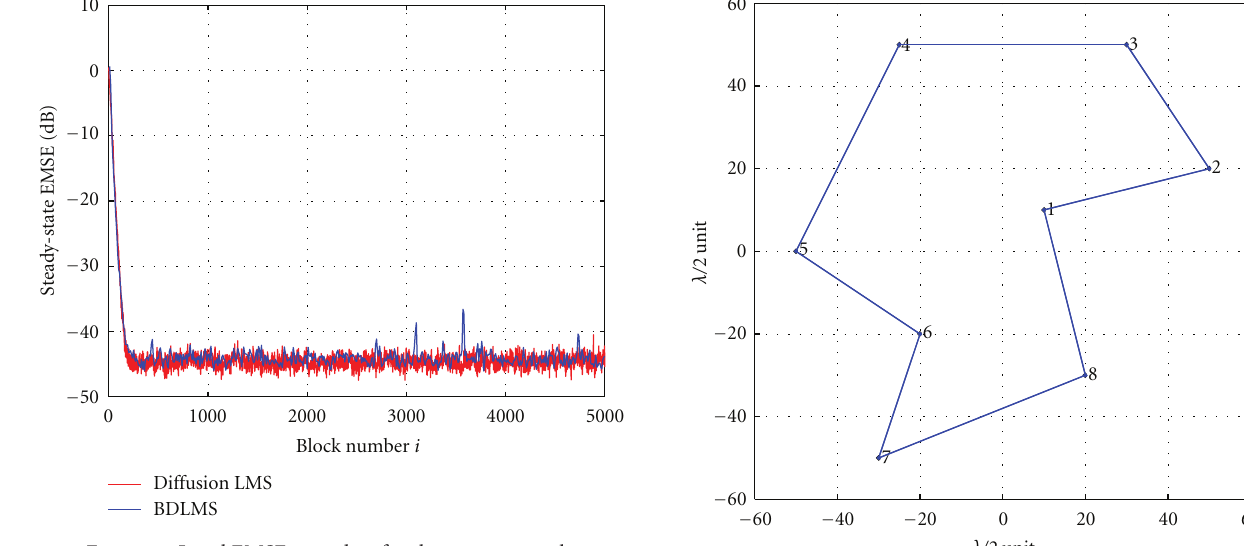
Figure 7: Local EMSE at node 7 for the same network.